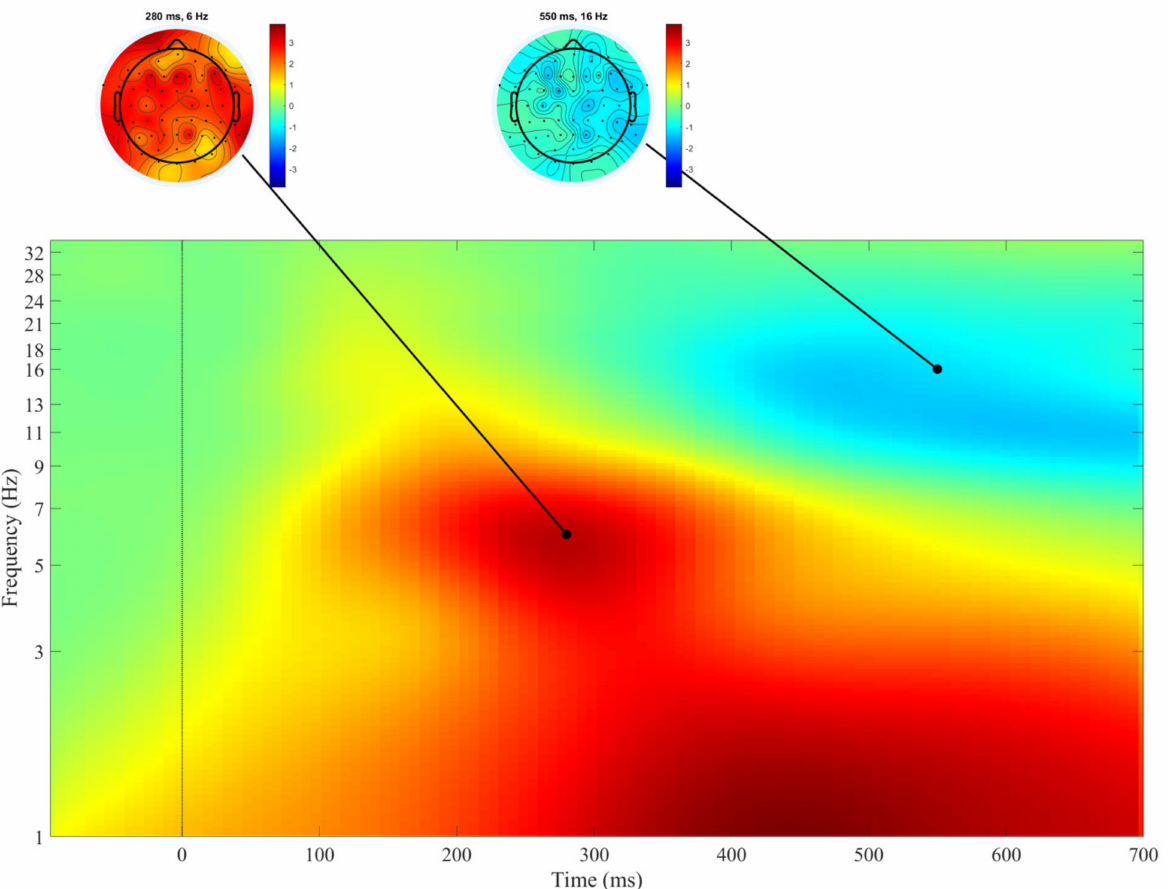
Figure 1. Averaged event-related spectral perturbations (ERSPs) (log test–log baseline) across all electrodes and all subjects in the Go condition. The cortical distribution of the most pronounced effects is displayed by the cortical maps at the top of the figure. An increase in spectral power is illustrated by warm colors, a decrease in spectral power by cool colors. The moment when the stimulus was presented is represented by 0. n =